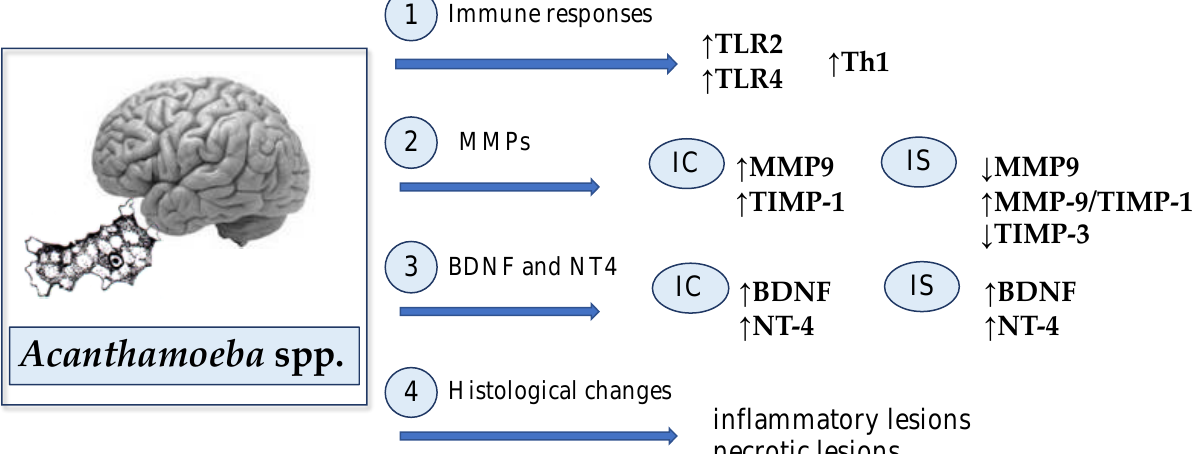
Figure 1. Host defense mechanisms against Acanthamoeba spp. infection in the brain: 1. Acanthamoeba spp. infection affects the growth of Toll-like receptors (TLR) expression, mainly TLR2 and TLR4. Moreover, it was found that antigen- sensitized lymphocytes from the brain of Acanthamoeba spp. infected mice contain mostly Th1 cytokine-producing cells; 2. Acanthamoebiasis causes an increase in the activity of metalloproteinases-9 (MMP-9) and the tissue inhibitor of metalloproteinases-1 (TIMP-1) in immunocompetent hosts (IC), and a decrease in MMP-9 and TIMP-3 in immunosuppressed hosts (IS). In immunocompromised hosts, an increase in the ratio of MMP-9/ TIMP-1 was also observed; 3. Acanthamoeba spp. infection affects the growth of brain derived neurotrophic factor (BDNF) and neurotrophin-4 (NT-4) activity in both immunocompetent (IC) and immunosuppressed (IS) hosts; 4. The amoebas induced inflammatory and necrotic lesions in the brain